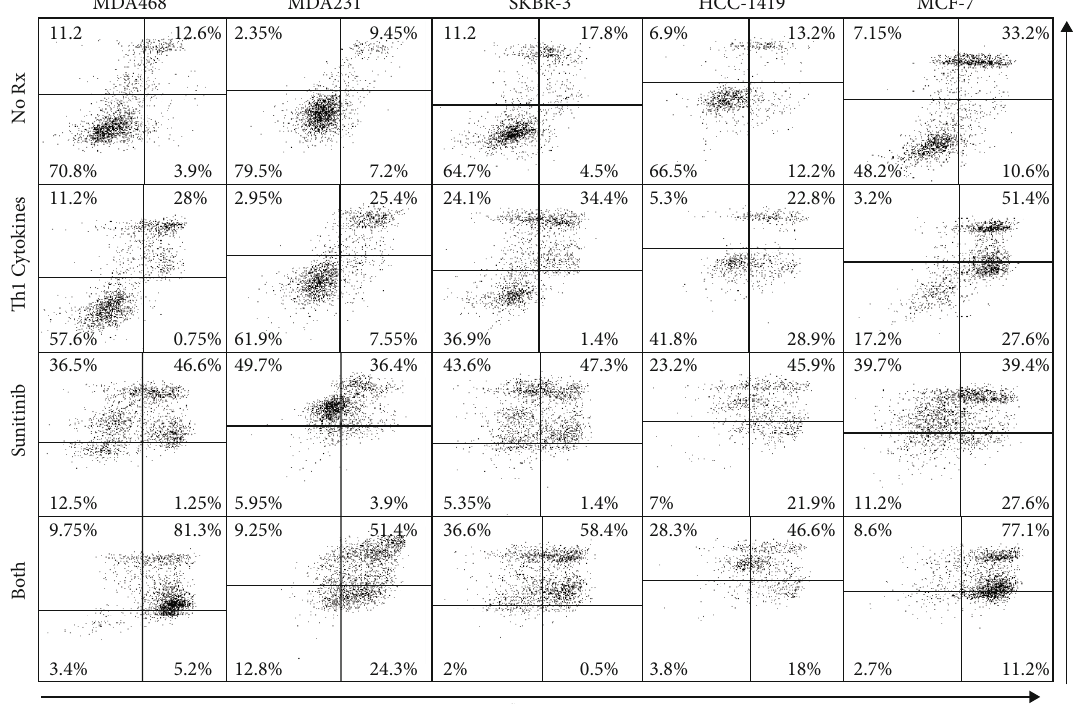
Figure 3: Combination of Th1 cytokines and sunitinib maximizes markers of apoptosis in breast cancer cell lines. MDA-MB-468, MDA-MB-231, SKBR-3, HCC-1419, and MCF-7 cells were seeded at 5 × 10 4 per mL and were left either untreated (No Rx) or treated with Th1 cytokines (5ng/mL), sunitinib (10 μ M), or sunitinib and Th1 cytokines (both) for 72 hours. Cells were then harvested and stained with FITC-Annexin V and propidium iodide (PI), and stain uptake was assessed by fl ow cytometry. Two-color dot plot analysis displays the percentage of cells in each quadrant. Double-stained cells (upper right quadrants) indicate late apoptotic events. Dot plots shown are from one representative experiment of three total showing similar breast cancer cell lines with Th1 cytokines and sunitinib